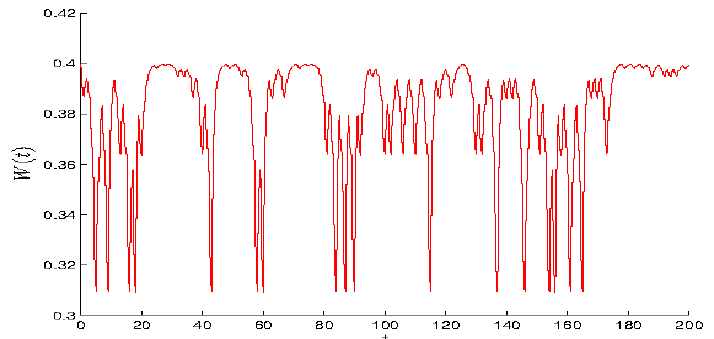
Figure 6. The solution W ( t ) of Equation (12) with initial value W ( 0 ) = 0.4 exponentially approaches the unpredictable Markovian